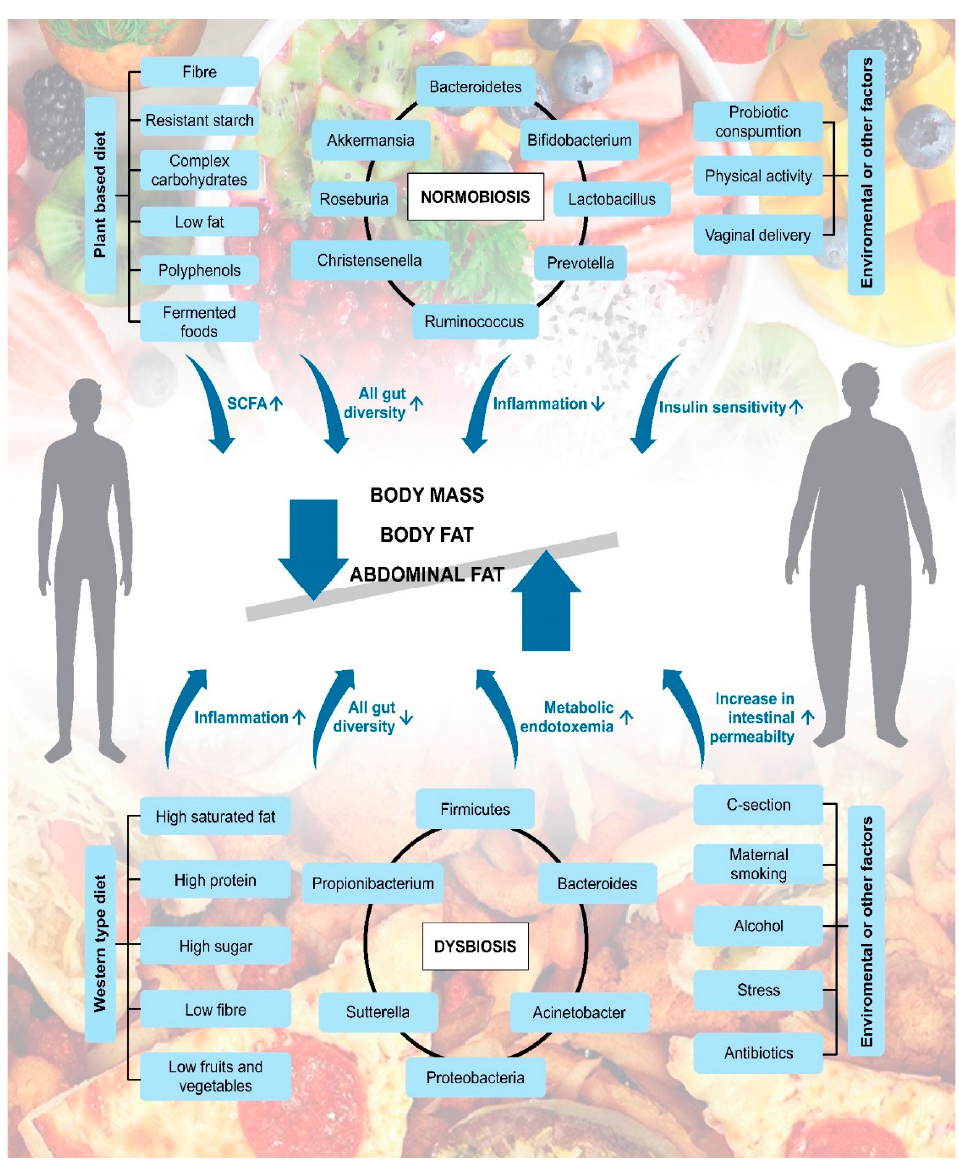
Figure 1. Dietary and environmental factors influencing the growth of some bacteria responsible for normobiosis or dysbiosis, causing an increase or decrease in body weight through various